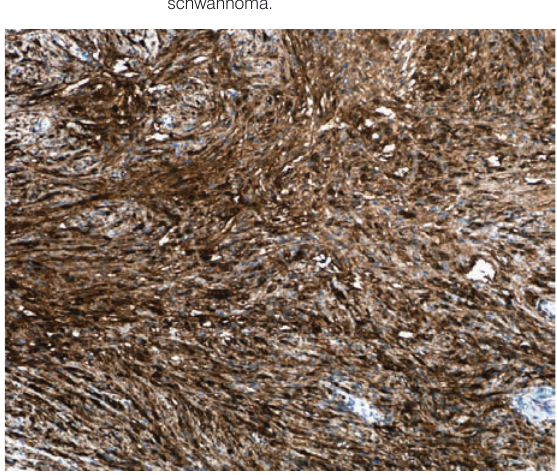
Figure 5. Strong immunoreactivity for S-100 protein in schwannoma.